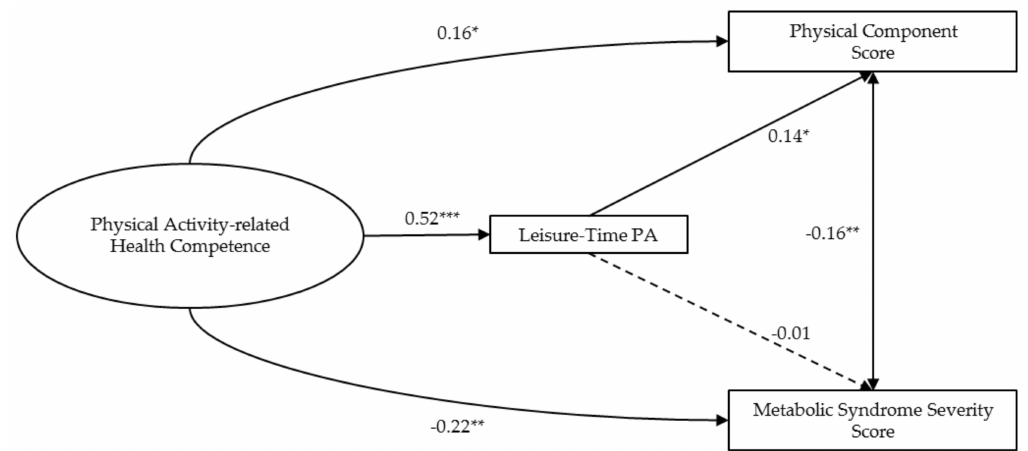
Figure 2. Standardized path coefficients for the predictor, mediator, and criterion variables. Notes. * p < 0.05, ** p < 0.01, *** p < 0.001; For simplification, first-order factors, manifest variables of the PAHCO Questionnaire, and covariates are not reported in the